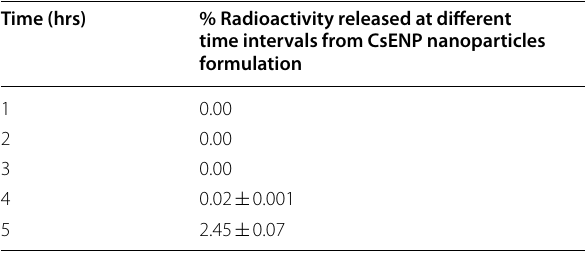
The values represent mean